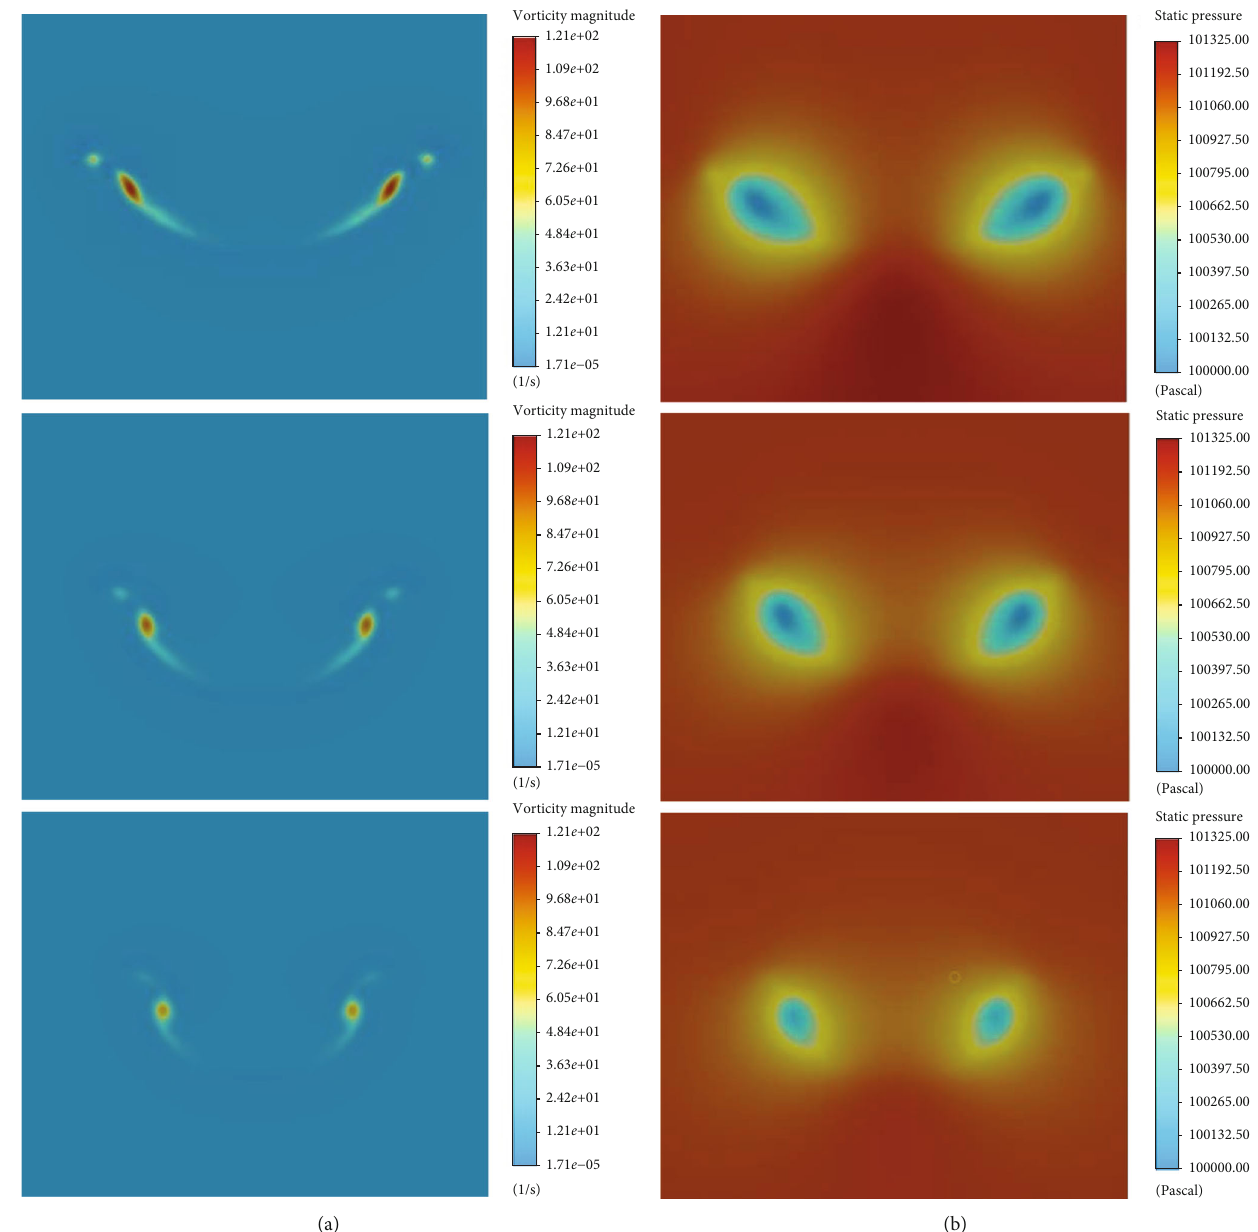
Figure 7: The development of wing tip vortices: (a) vorticity contour and (b) pressure